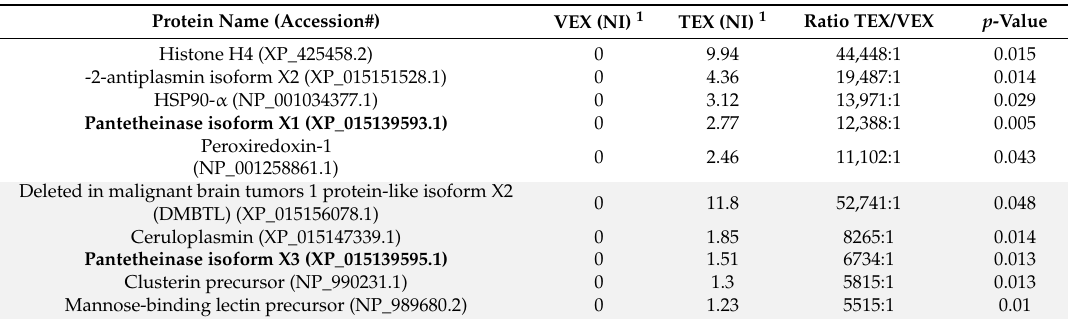
Table 6. Serum TEX-overrepresented